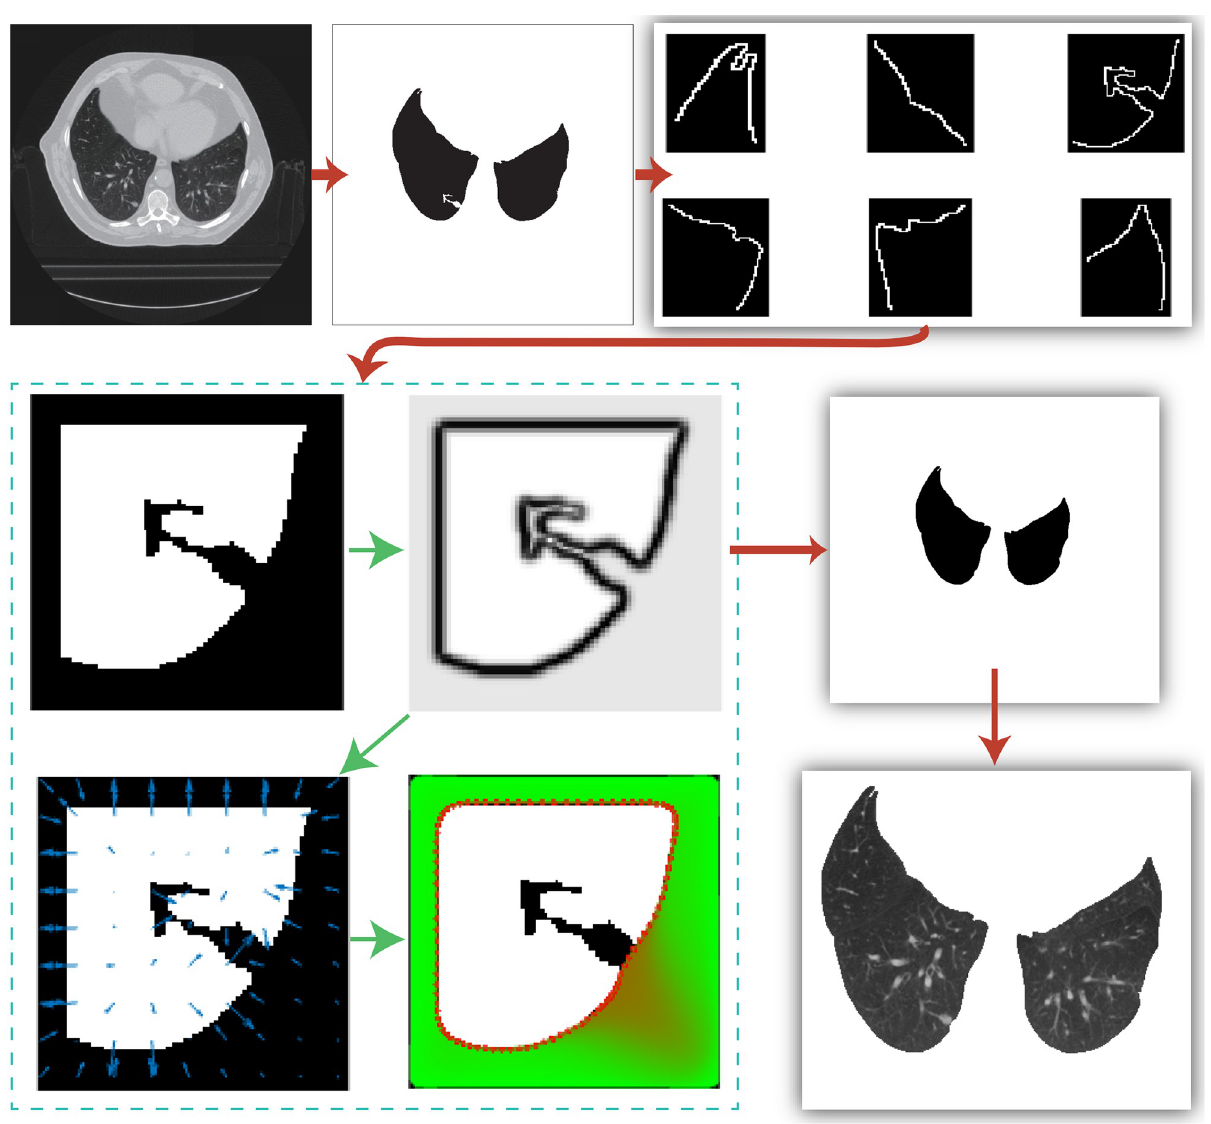
Fig 14. The segmentation results in the CT slice